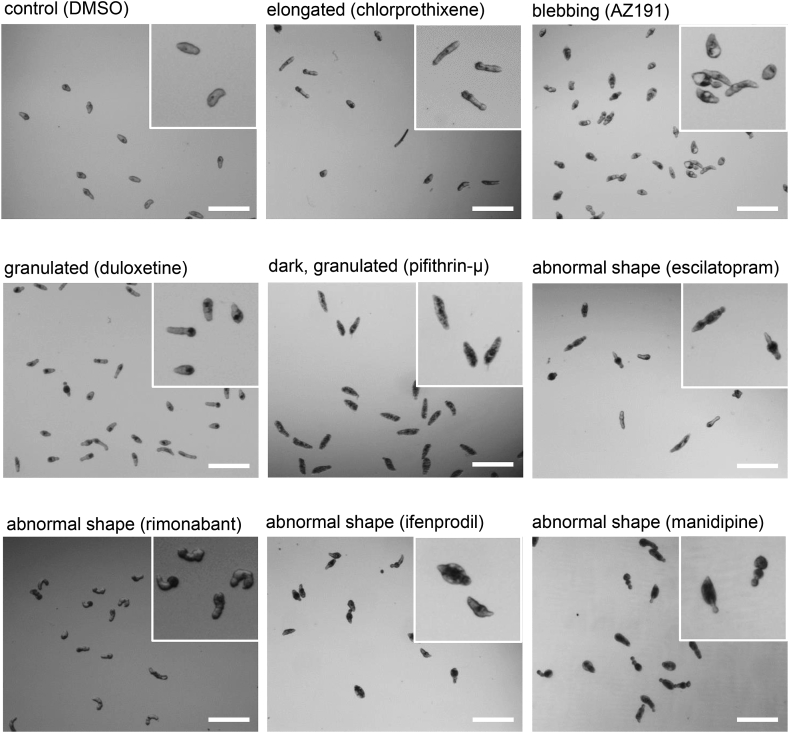
Compound-related morphological impact on schistosomulae.Three-day old shistosomulae were exposed for 24 h to 10 μM of each selected compound. Images were obtained five days post drug exposure. The images represent the main observable phenotypes in comparison to control animals treated with vehicle only (DMSO). Magnified caption is represented in the upper right corner of each image. Bars indicate 300 μm.